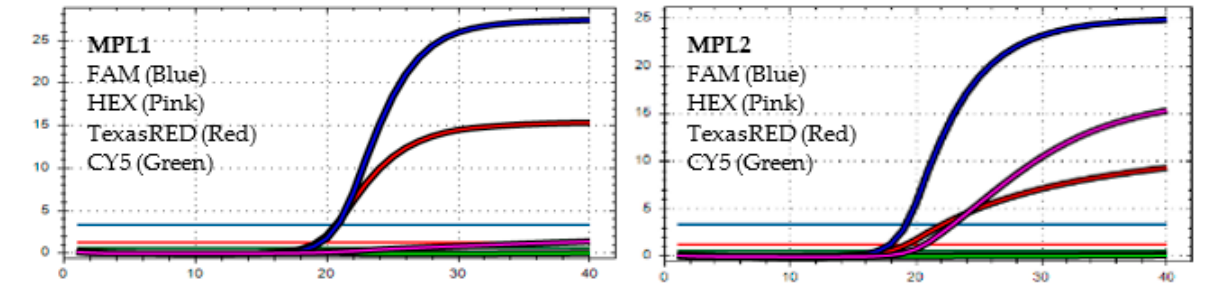
Figure 5. In MPL1 , the target failures are detected in 2 channels, HEX and CY5. In MPL2 , no target failure is detected in 3 channels, FAM, HEX, and TexasRED. No amplification is detected in channel CY5 because of the competition of high viral load with the IC (human RNAse P). This pattern is identified as variant BA.5 .